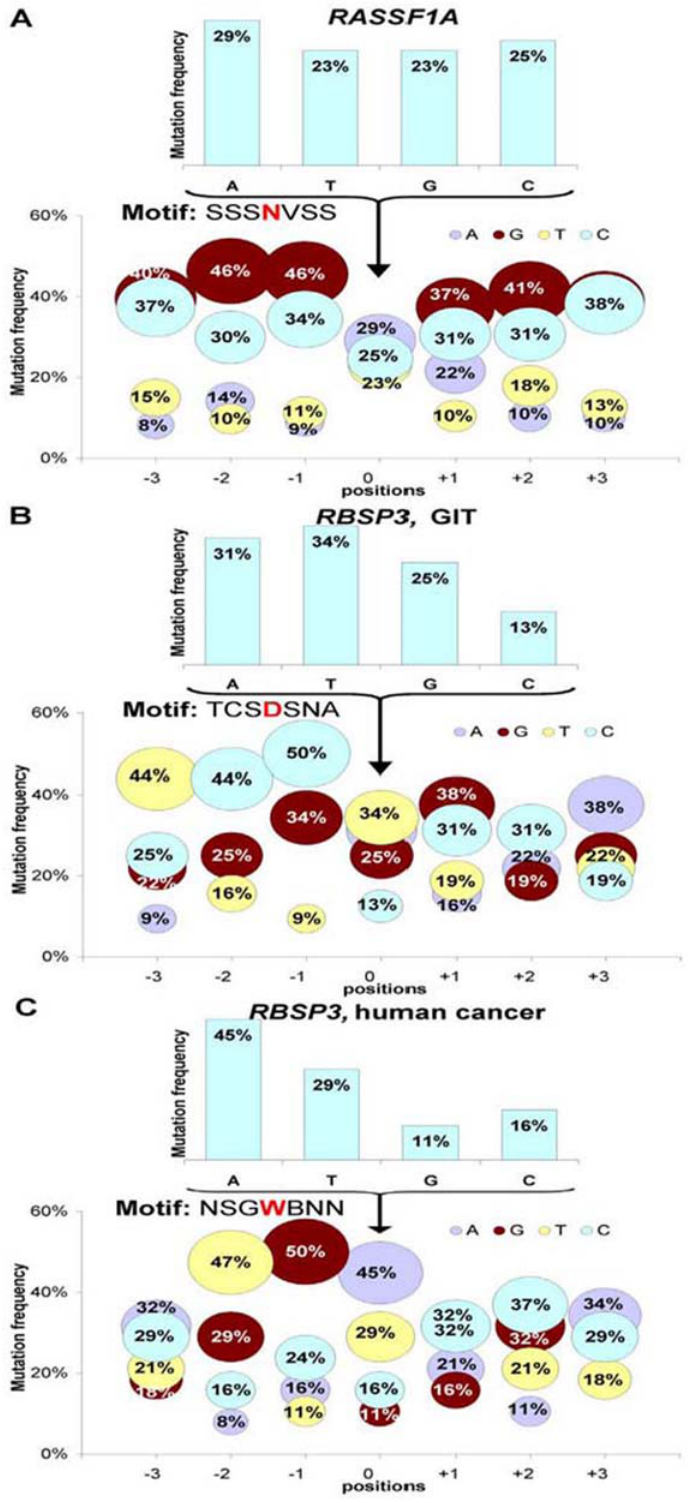
Figure 3. Distribution of mutations in RASSF1A ( A ) and RBSP3 ( B and C ). For RASSF1A all mutations were analyzed. For RBSP3 mutations found in GIT ( B ) and in human cancer ( C ) were analyzed separately. Bubble graphs depict the proportion of substitutions occurring at each of the four bases in the RASSF1A and RBSP3 , depending on the distance from the mutated nucleotide (No. 0). N, any nucleotide;B=C, G or T; D=A, G or T; S=G or C; V=A,C, or G; W=A or T.